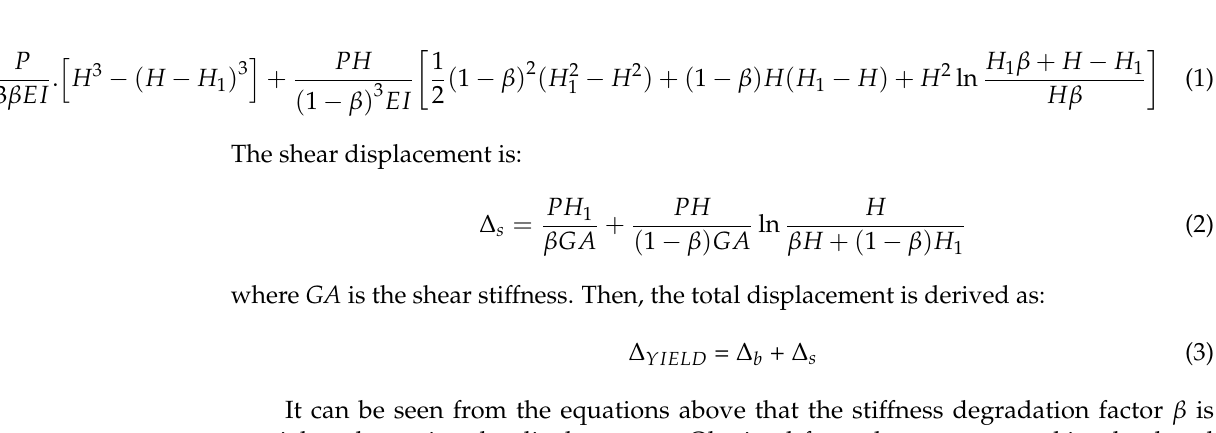
Table 1. Comparison of calculated displacement and test displacement.